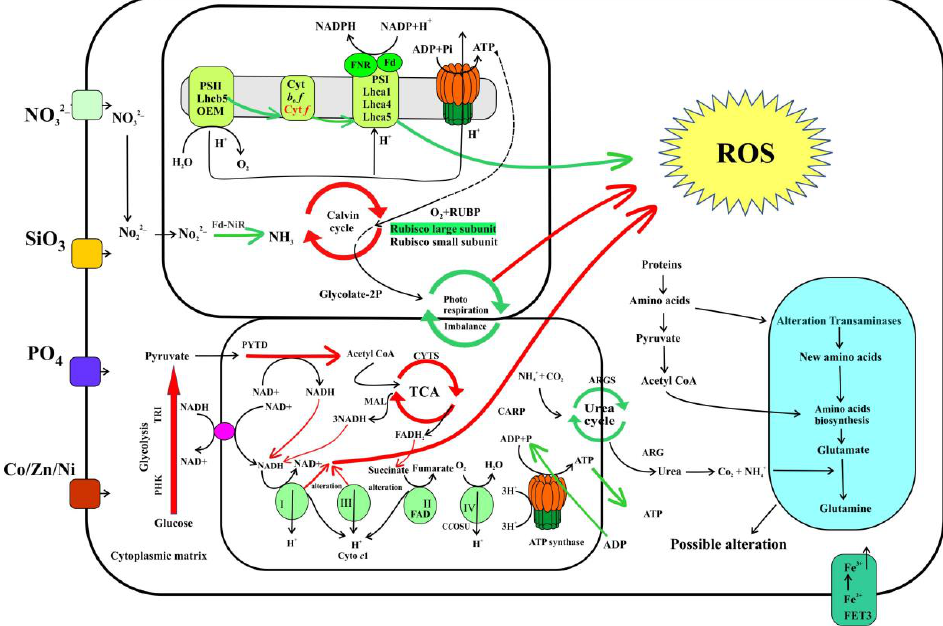
Figure 6. Identified energy and carbon metabolomic pathways and processes of S. dohrnii under Si-limited-Si-added condition. All red arrows indicate up-regulated proteins and processes and green shows downregulation proteins and processes. PS: photosystem, Lhc: light-harvesting complex, OEM: oxygen-evolving complex, Cyt: cytochrome, Fd: ferredoxin; FNR: ferredoxin-NADP+, Fd-NiR: ferredoxin nitrite reductase; TCA: tricarboxylic acid, RUBO: RuBisCO; ROS: reactive oxygen species, PHK: phosphoglycerate kinase; TRI: triosephosphate isomerase; PYTD: pyruvate dehydrogenase; CYTS: citrate synthase; MAL: malate / lactate dehydrogenase; CARP: carbamoyl-phosphate synthase; ARGS: argininosuccinate synthase; ARG: arginase, complex I; NADH ubiquinone reductase, complex III; cytochrome c